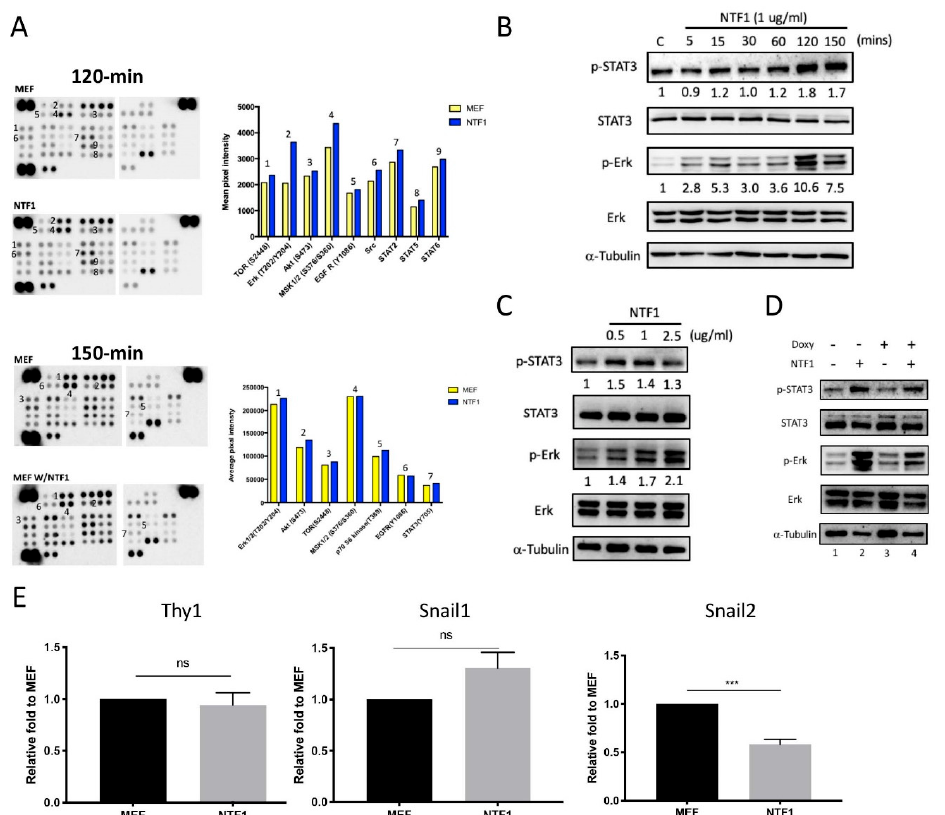
Figure 3. STAT3 and Erk1/2 regulated Snail2 expression are the potential signal transducers activated by NTF1 ( A ) Identification of the NTF1-mediated signal transducers through blotting of the phospho-kinase array. After 24-h serum starvation, MEF Col1a1 4F2A Oct4-GFP cells treated with NTF1 for 120 and 150 min were subjected to the phospho-kinase array analysis, and untreated MEFs Col1a1 4F2A Oct4-GFP served as the control. The numbers labeled on the bar graph correspond to the numbers on the blot images. The upper panel shows the 120 min NTF1 treatment, whereas the lower panel displays the 150 min treatment. ( B ) The time-dependent effect of NTF1 treatment on the phosphorylation of STAT3 and Erk1/2. After 24-h of serum starvation, MEF Col1a1 4F2A Oct4-GFP cells were subjected to a time-course experiment via treatment with 1 µ g/mL NTF1 for 5, 15, 30, 60, 120, or 150 min. The NTF1-untreated MEF Col1a1 4F2A Oct4-GFP cells served as the control. In the 120 min NTF1 treatment group, both phosphorylated STAT3 and Erk1/2 signals reached a plateau on the blot. ( C ) The dose-dependent effect of NTF1 treatment. MEF Col1a1 4F2A Oct4-GFP cells were subjected to different concentrations of NTF1 (0.5, 1, and 2.5 µ g/mL). Both the phosphorylated STAT3 and Erk1/2 signals reached a plateau at 1 µ g/mL after 120 min of NTF1 treatment. Untreated MEF Col1a1 4F2A Oct4-GFP cells served as the control. ( D ) The effects of NTF1 treatment in the presence of doxycycline. After 24 h of serum starvation, MEF Col1a1 4F2A Oct4-GFP cells were simultaneously subjected to NTF1 and doxycycline treatment for 120 min. ( E ) A comparative analysis of the MET-associated genes, including Snail1, Snail2, and Thy1, revealed that Snail2 is the downstream effector of NTF1 treatment targeted by STAT3 and Erk1/2. ( n = 3). ***, p < 0.0005; ns, not